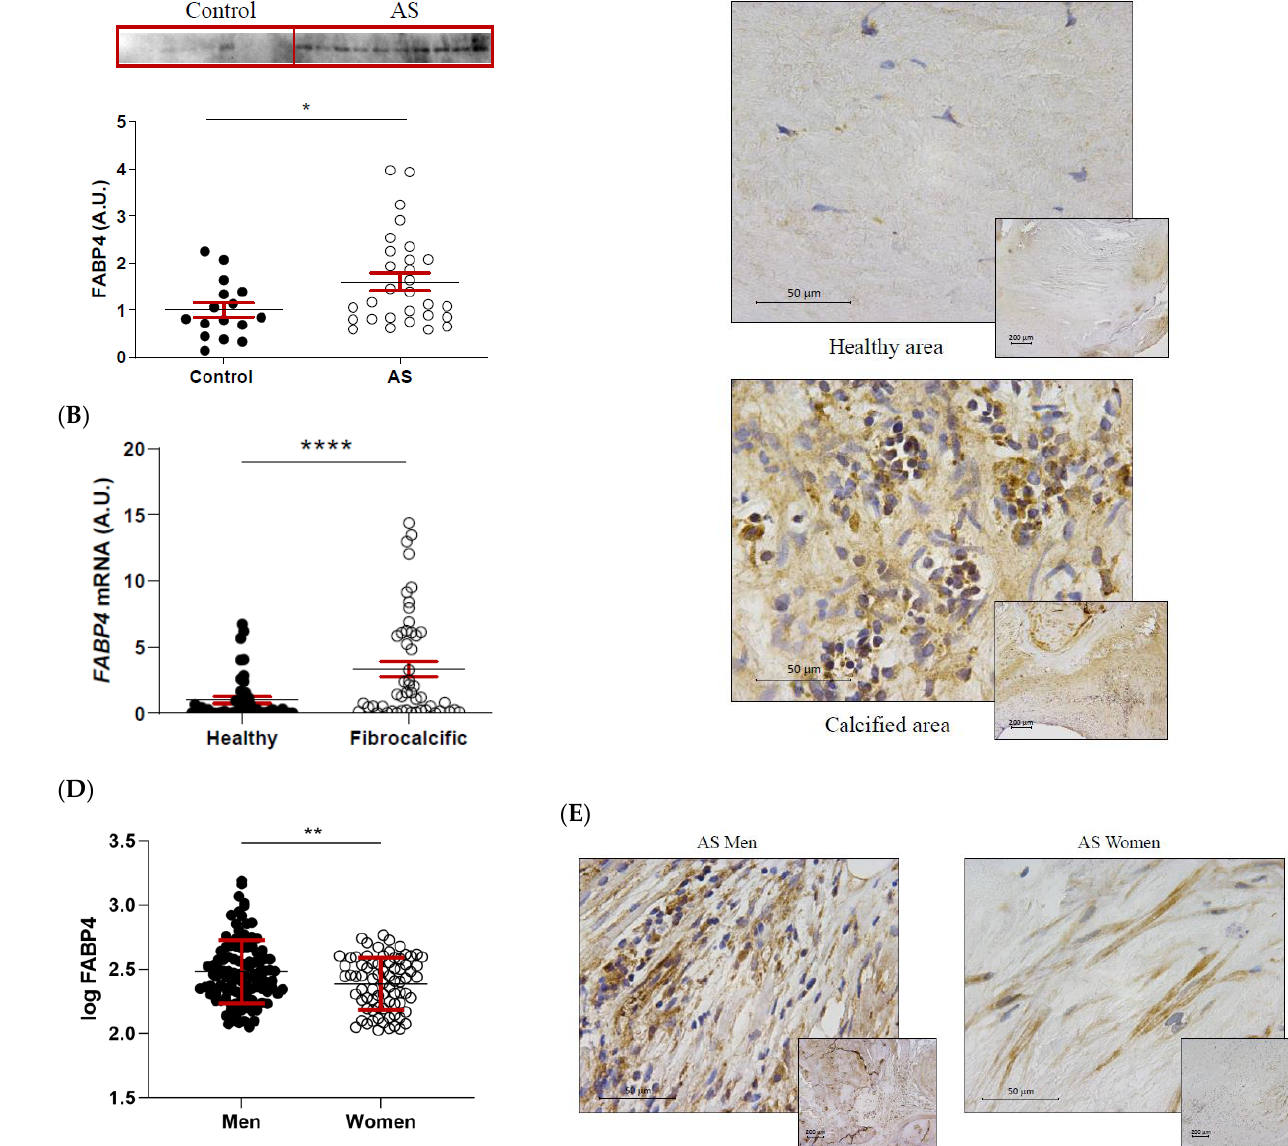
Figure 2. The differential expression of FABP4 in AS valves according to tissue damage and sex. ( A ) The protein expression of FABP4 in tissue homogenates from AVs of the control and AS patients. ( B ) The mRNA expression levels of FABP4 in the AVs of AS patients separated by their macroscopic healthy or fibrocalcific status. ( C ) Representative microphotographs of healthy and calcified AV sections of AS patients immunostained for FABP4. ( D ) Protein expression levels of FABP4 in tissue homogenates from the AVs of male and female AS patients. ( E ) Representative microphotographs of AV sections from men and women with AS immunostained for FABP4. Dot plots represent the mean and standard error of the mean (SEM) of each group of subjects (Control AV N = 16 vs. AS valves N = 29; Healthy N = 54 vs. Fibrocalcific N = 50; Men N = 109 vs. Women N = 77). Protein levels were measured by Western blot (normalized to stain free protein, A.U.: arbitrary units) or ELISA. The mRNA expression levels (A.U.) were normalized to the 18S , HPRT , ACTB , and GADPH levels and healthy group was used as the calibrator. AV: aortic valve; AS: aortic stenosis; AU: arbitrary units; FABP4: fatty acid-binding protein 4. * p < 0.05, ** p < 0.01, **** p < 0.0001.